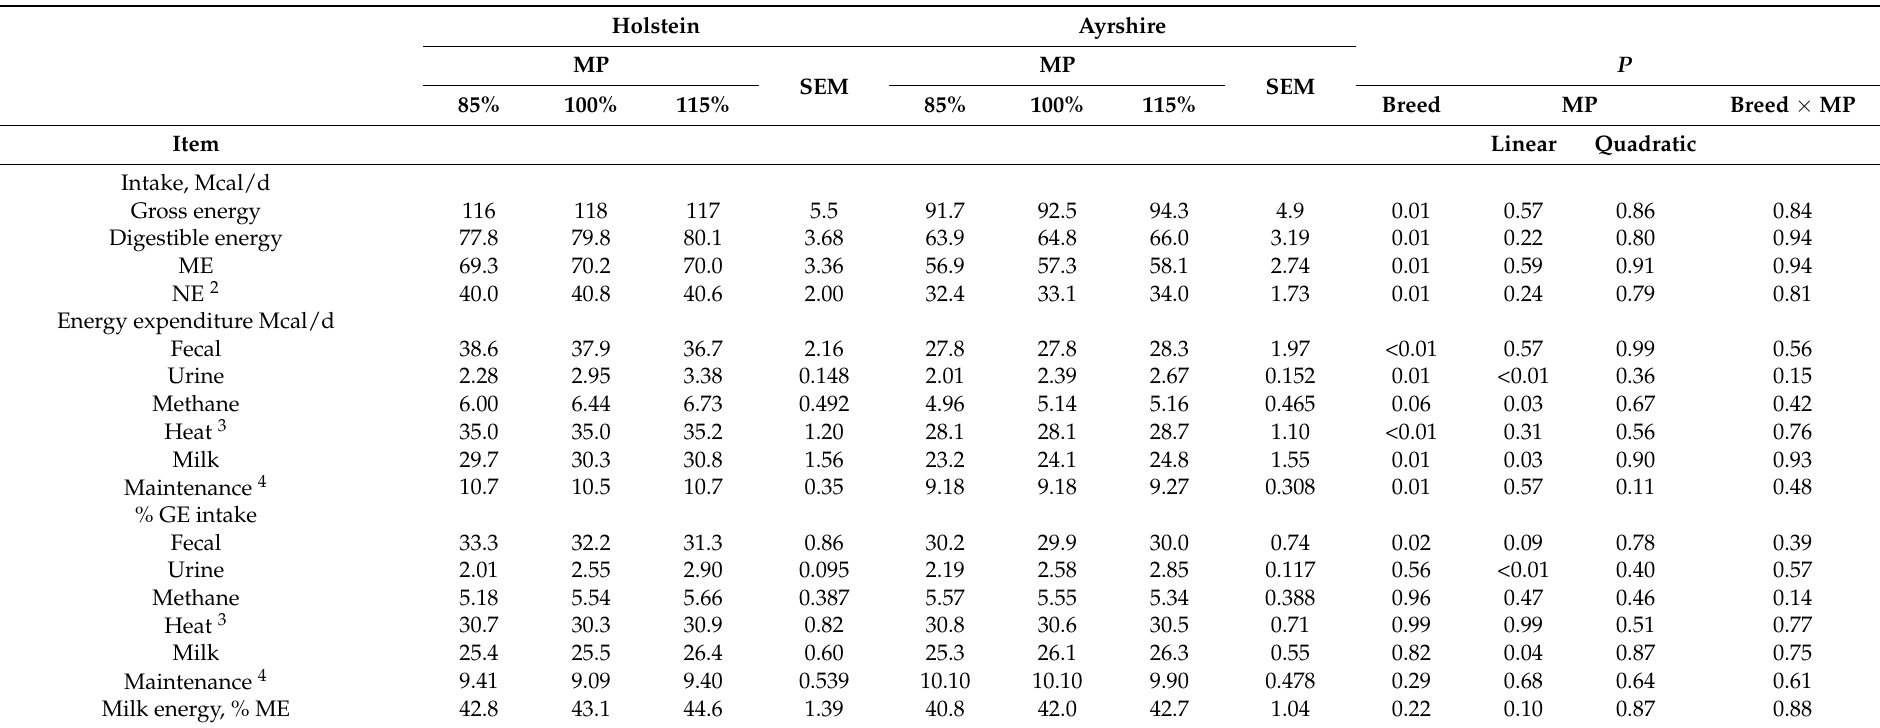
Table 7. Energy intake, expenditure and partitioning in lactating Holstein and Ayrshire cows fed diets formulated to provide 85%, 100%, or 115% of metabolizable protein (MP) requirement 1